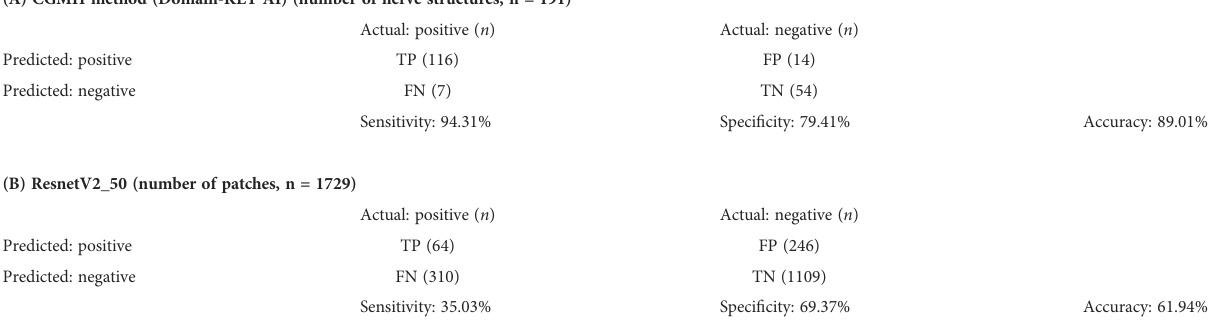
TABLE 4 Confusion matrix and testing performance of the model for identifying perineural invasion (Regions of Interest), Domain-KEY AI model versus ResnetV2_50 model. (A) CGMH method (Domain-KEY AI) (number of nerve structures, n =